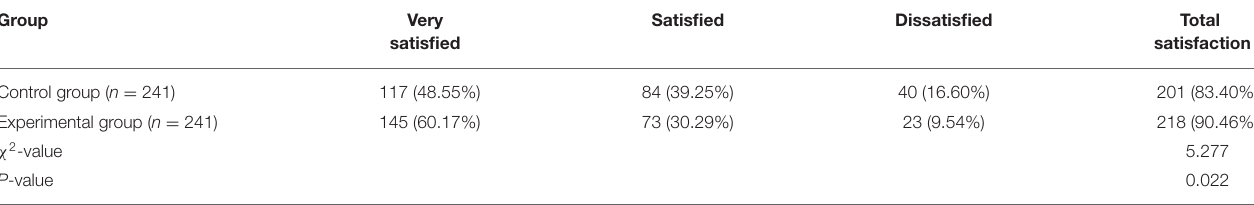
TABLE 2 | Satisfaction of two groups ( n ,